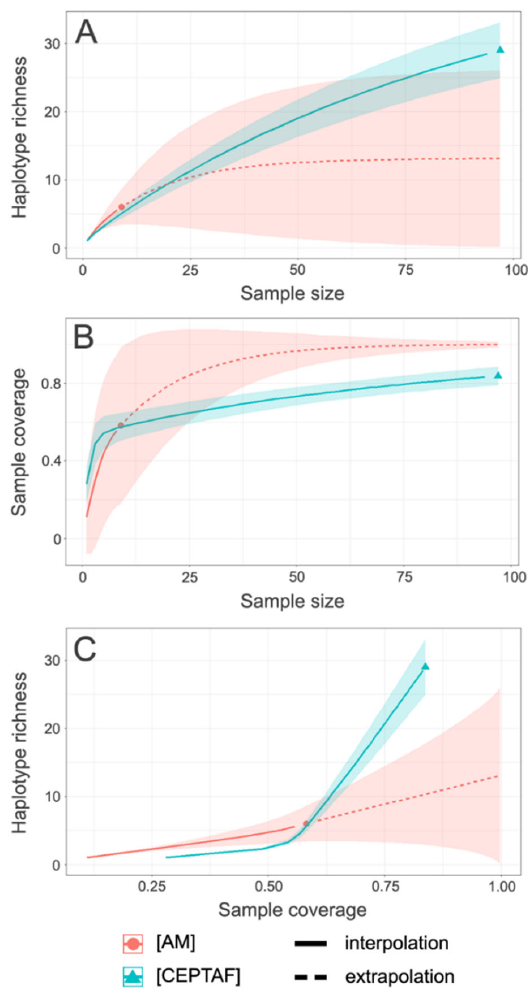
Figure 4. Rarefaction and extrapolation haplotype richness curves for the two clusters of giant anteaters. Three types of curves are shown: ( A ) a sample size-based, ( B ) a sample completeness, and ( C ) a coverage-based curve. Solid lines are a result of interpolation and dashed lines represent extrapolation. Lighter areas around the asymptote delimit the 95% confidence intervals. AM: Amazon cluster; CEPTAF: Cerrado, Pantanal, and Atlantic Forest cluster.